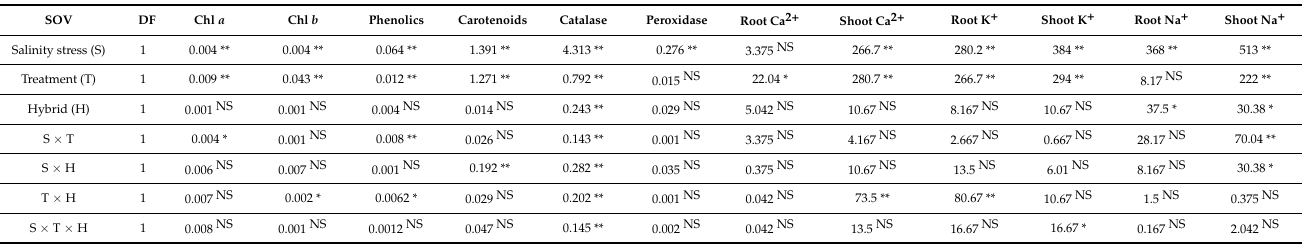
Table 2. Mean sum of squares of biochemical, antioxidants and mineral elements of sunflower hybrids grown under salinity stress environment in response to foliar applied